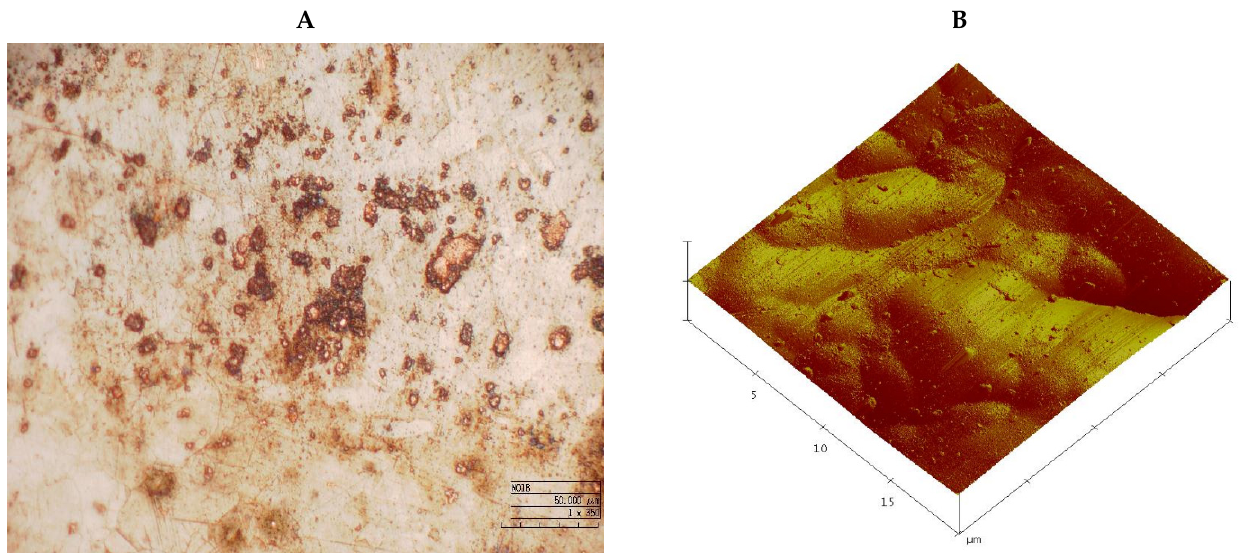
Figure 5. Comparative imagery of a copper sample electropolished with 1 M phosphoric acid. Digital microscopy ( A ) at 1 × 350 µm resolution displays surface marring resulting from pitting at low current densities. ( B ) AFM of a 20 × 20 µm area shows residual pitting on the copper surface. AFM Z -axis = 100 nm/div.